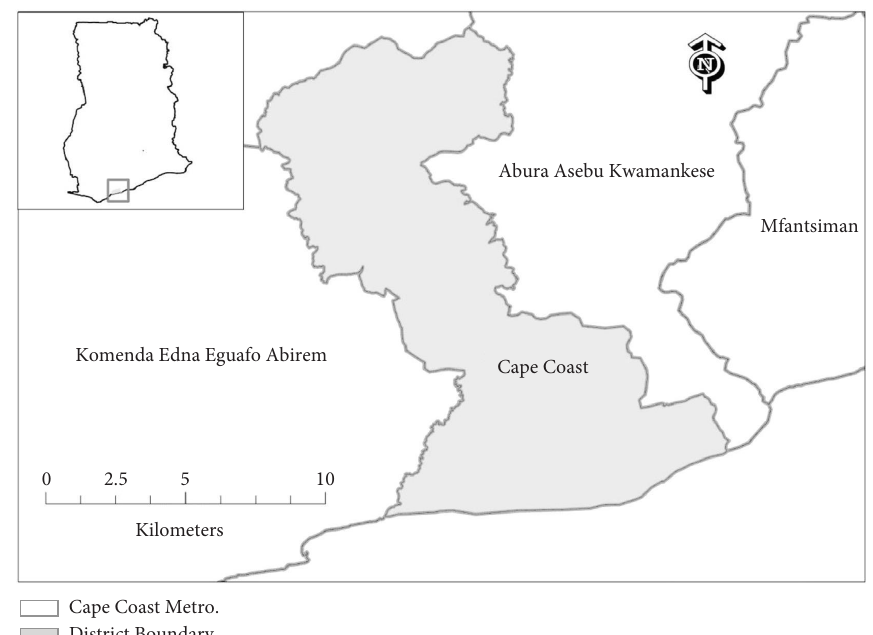
Figure 1: Map of the Cape Coast (credit: Ing. Dr. Charles Gyamf, Department of Civil Engineering, Kwame Nkrumah University of Science and Technology, Kumasi,